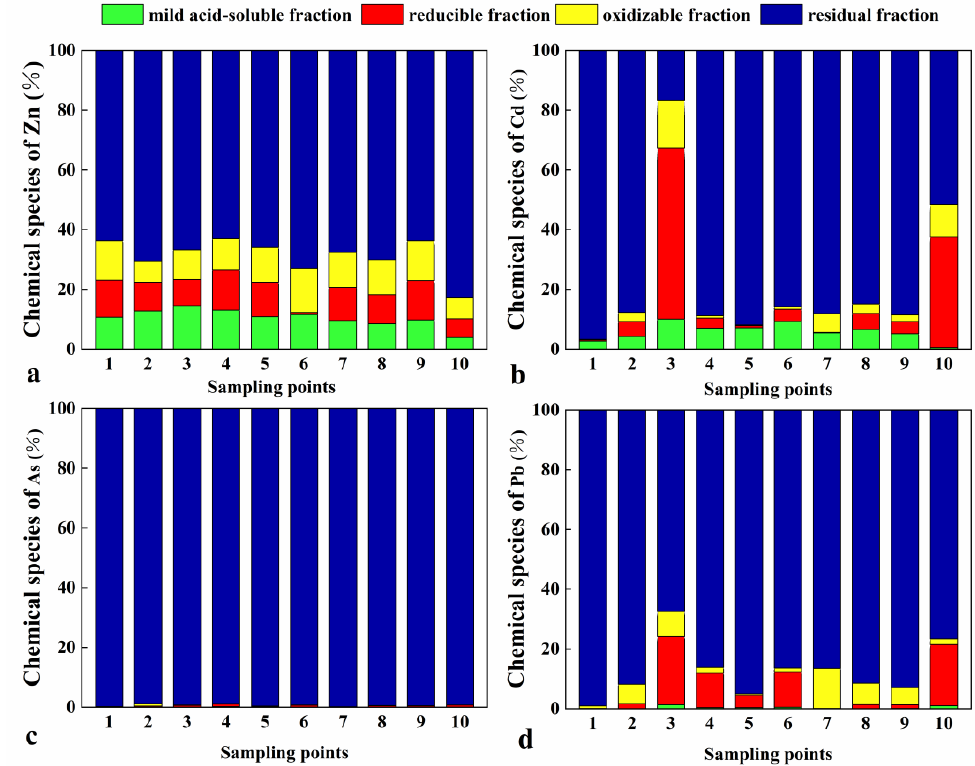
Figure 5. Chemical proportions of four characteristic heavy metals. Chemical species of: ( a ) Zn; ( b ) Cd; ( c ) As; ( d ) Pb. Sampling points are the same as in Figure 2.